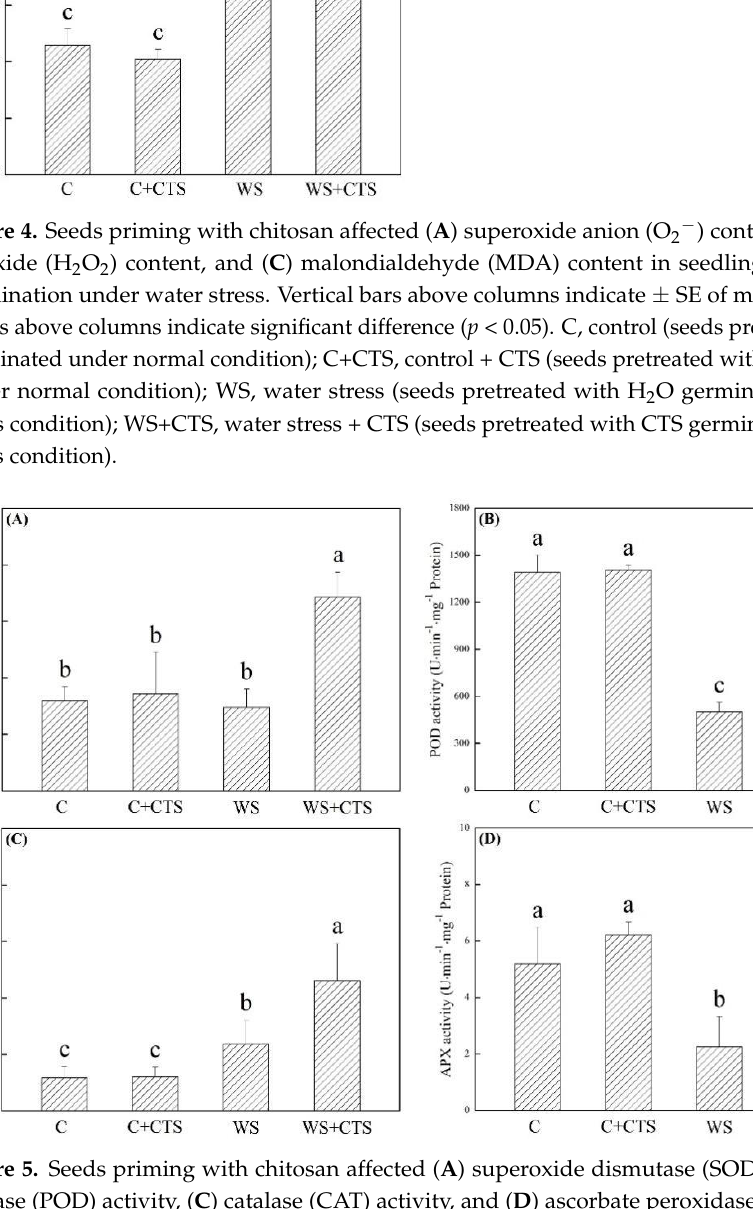
seedlings after 7 days of germination under water stress. Vertical bars above columns indicate ± SE